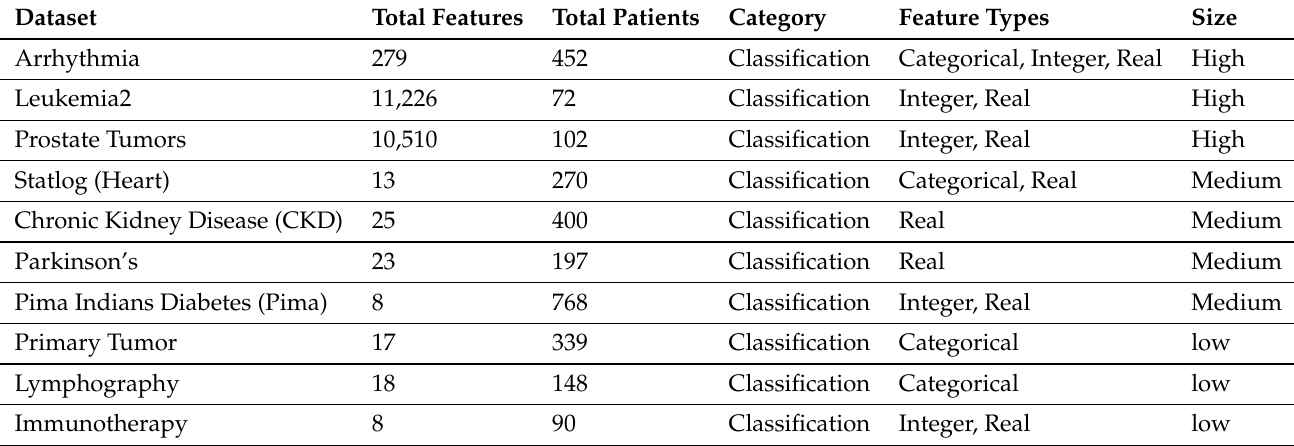
Table 4. Descriptions of disease